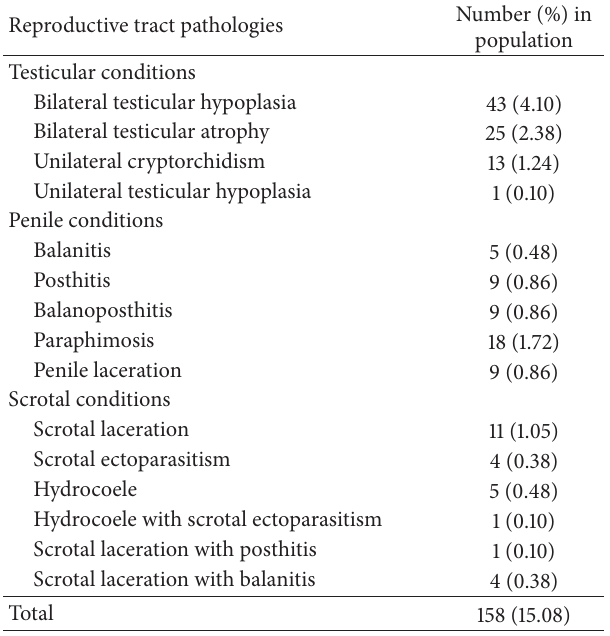
Table 1: Incidence of pathological conditions encountered in the male reproductive tracts of Sahel